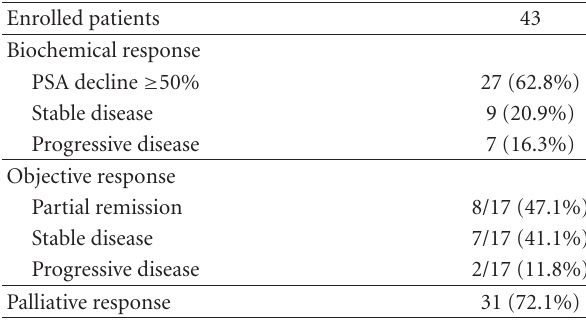
Table 3: Response to treatment.